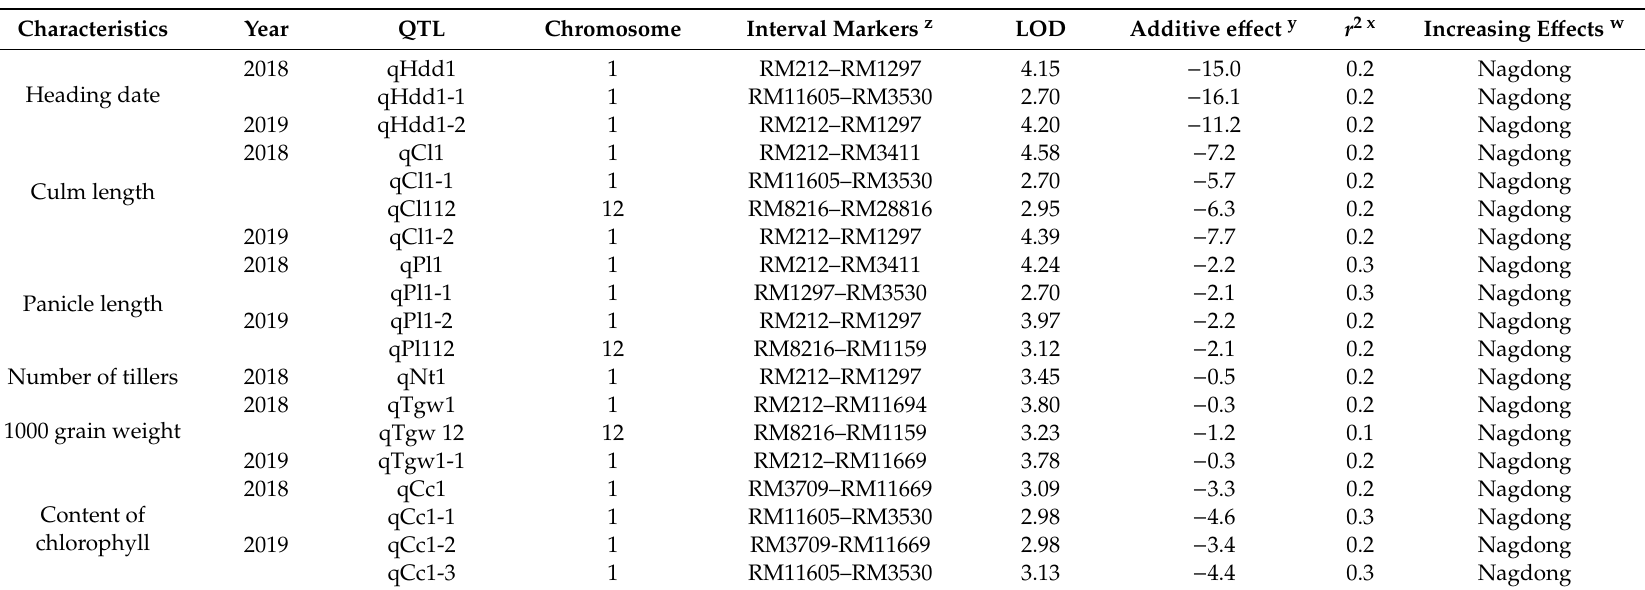
Table 2. QTL related to the agronomic characters of the Cheongcheong / Nagdong DH